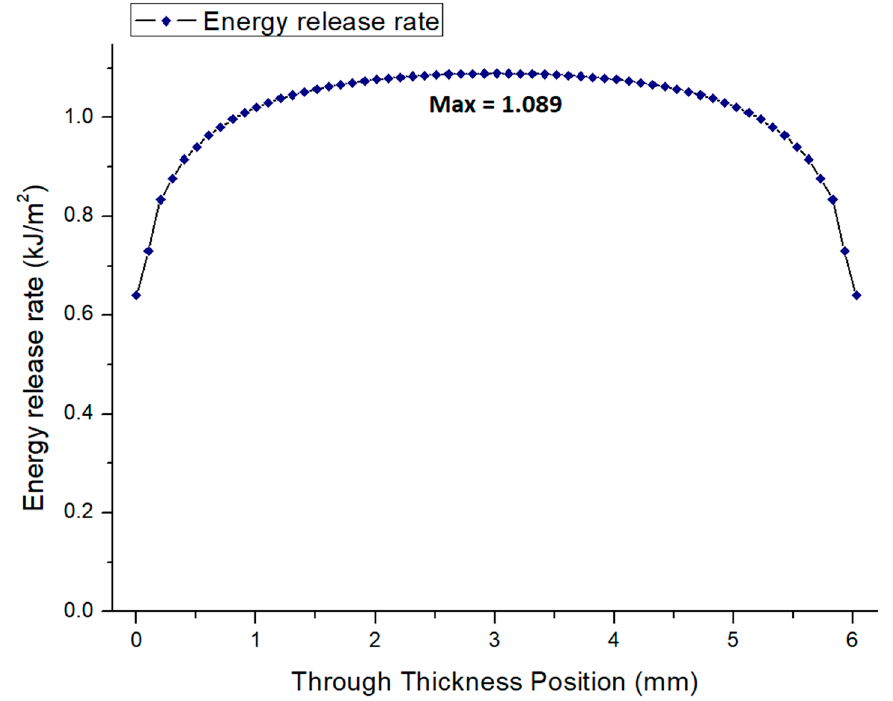
Figure 8. Evolution of the energy release rate in mode I for the SENB specimen in the thickness.